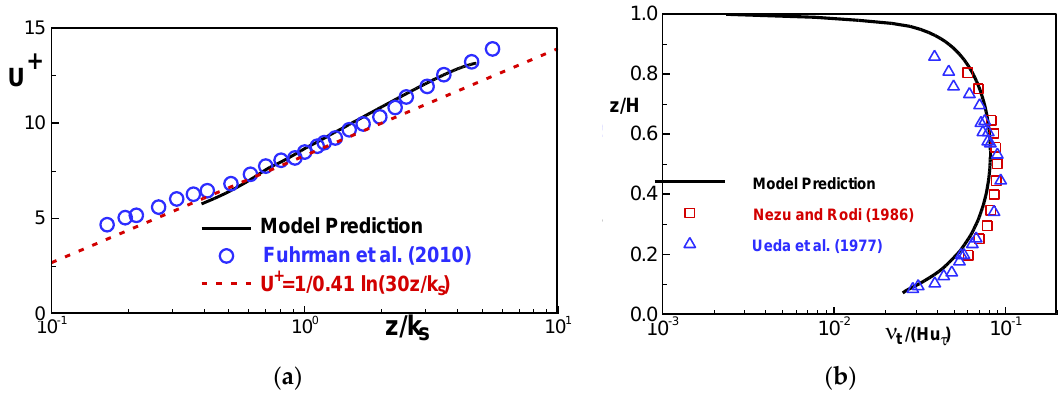
Figure 8. Comparison of predicted results with the measured data for the Fuhrman case. ( a ) velocity; ( b ) turbulent viscosity.